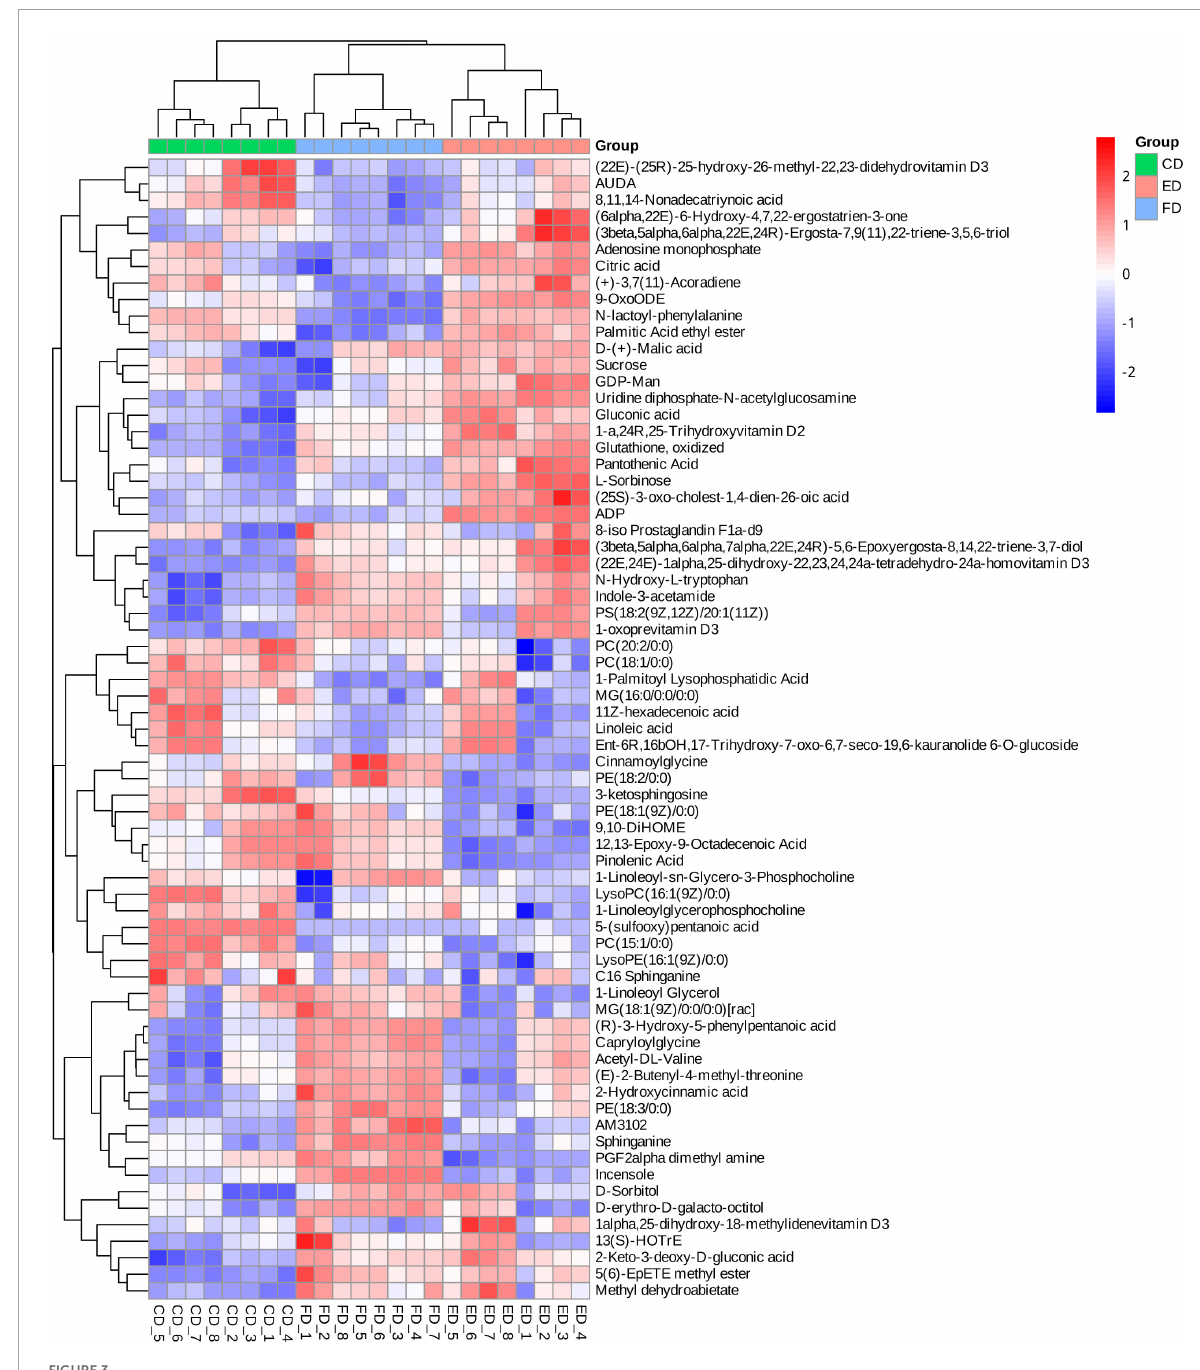
FIGURE3 Heatmap analysis of differential metabolite contents among the three drying methods.